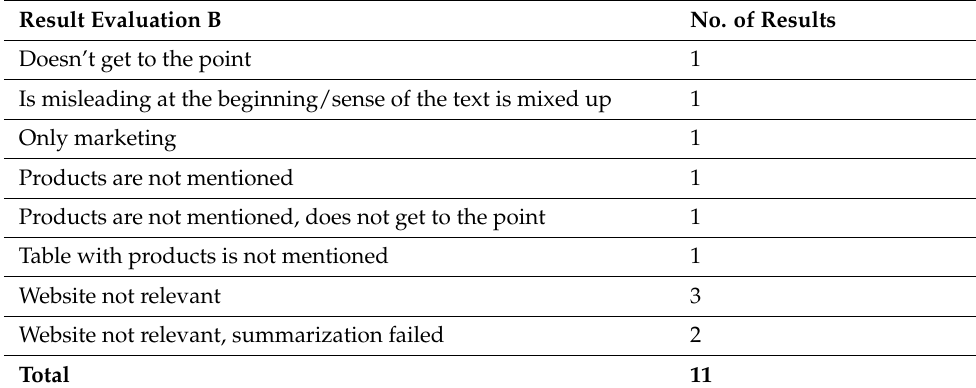
Table 4. Result evaluation B observations (match with content = yes, informative = no).